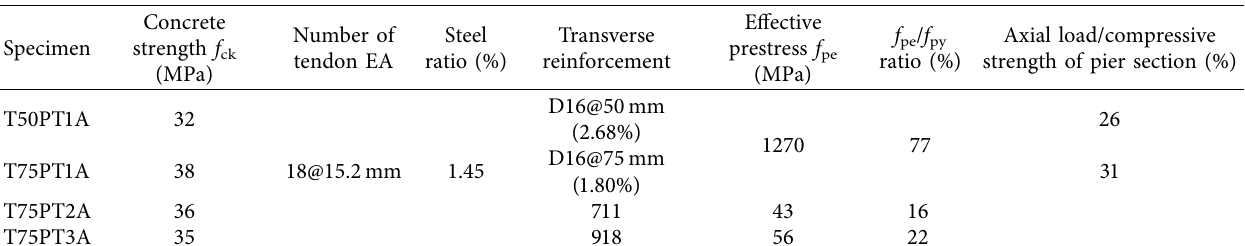
Figure 1: Specimen details (unit: Table 4: Test specimens.